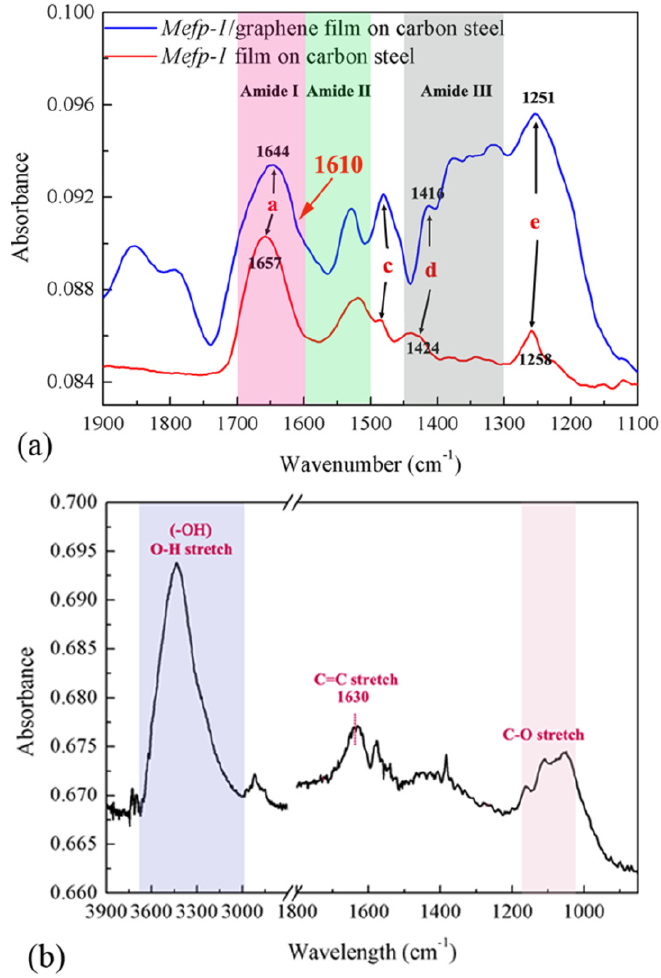
Figure 6. ( a ) Infrared spectra of Mefp -1 film and Mefp -1/graphene film grown on carbon steel surface for 60 min; ( b ) infrared spectra of pure dry graphene.